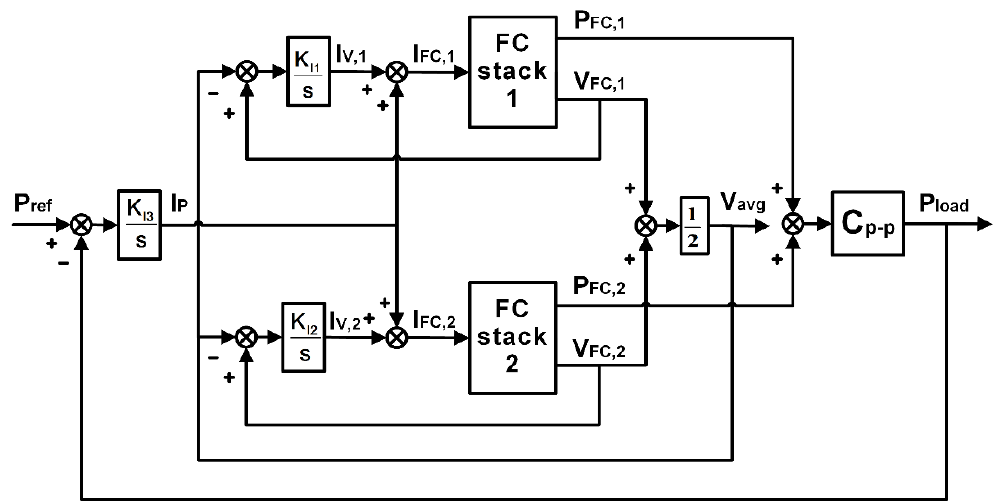
Figure 2. Proposed simulation method for the power-delivery operation of the parallel-connected stack system.